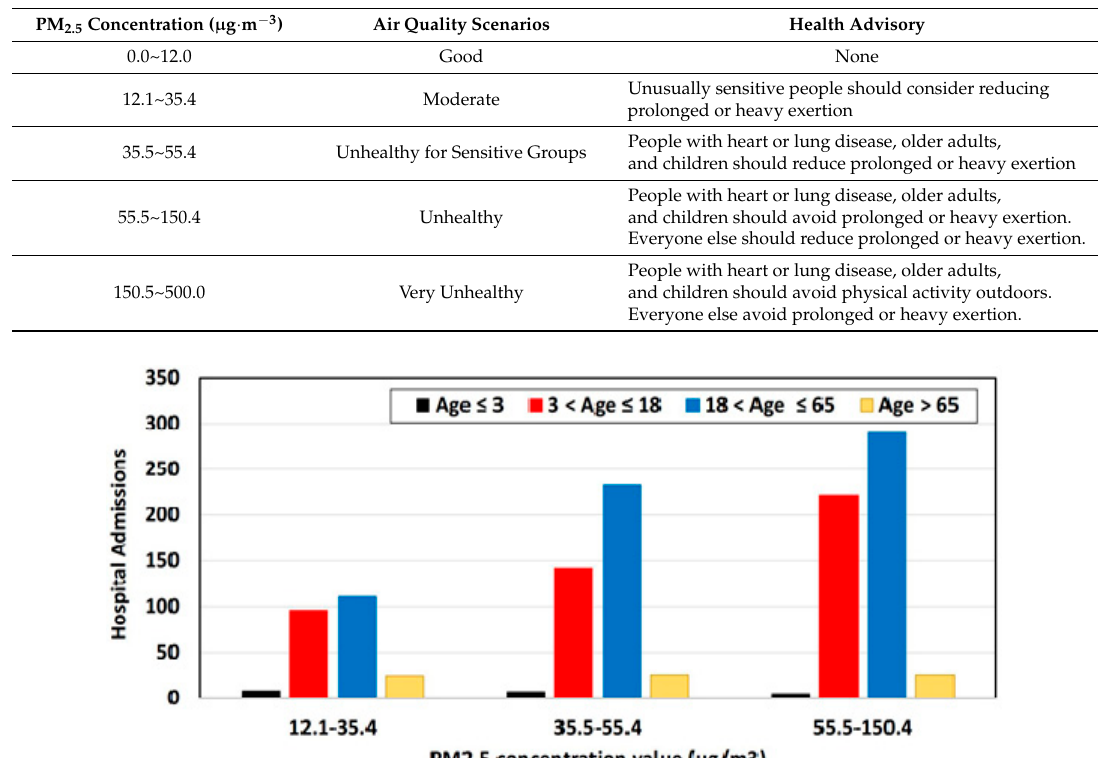
Table 3. Air quality index for particle pollution.